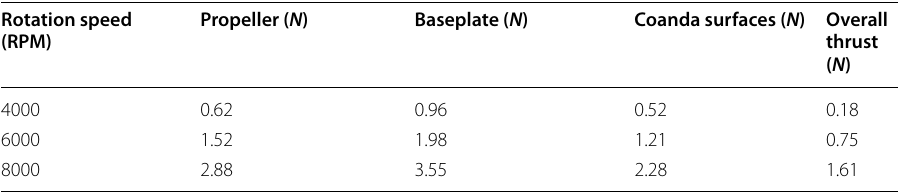
Table 3 CFD force distribution across different surfaces of novel design from 4000 RPM to 8000 RPM Rotation speed